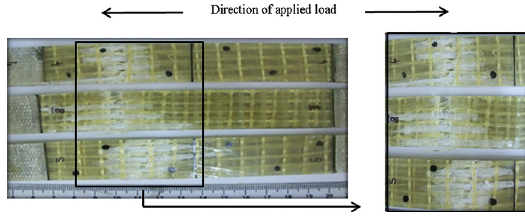
Figure 8. Fracture characteristic - HFCL laminate - uniaxial tensile.